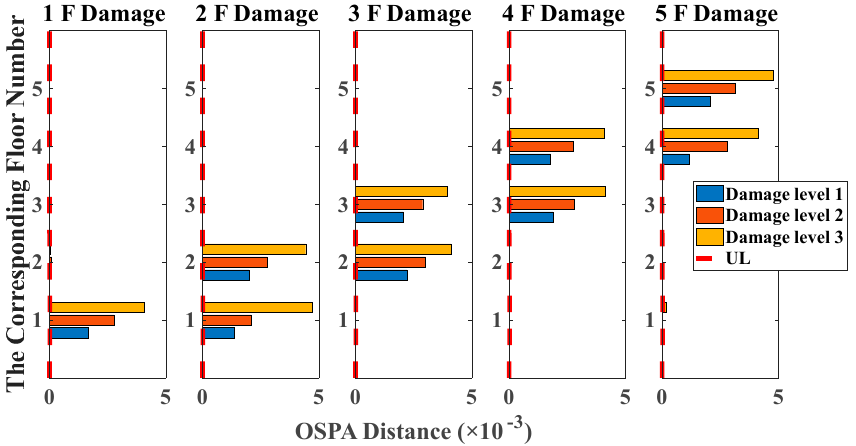
Figure 18. Damage detection results based on the OSPA distance (sine sweeping-frequency excitation, autoregressive model, data length = 4000, AR order = 1, OSPA.p = 2, Assignment = 1). Taking damage level 2 existing on the third floor as an illustrative example, the AIC plot of the third floor response modeled with AR model is shown in Figure 19, while R values of various AR orders are given in Figure 20. Figure 19. AIC of an AR model for the third floor response under the case of level 2 damage occurring on the third floor. . Figure 20. Evaluation index of damage detection results using various AR orders (the case of level 2 damage occurring on the third floor).